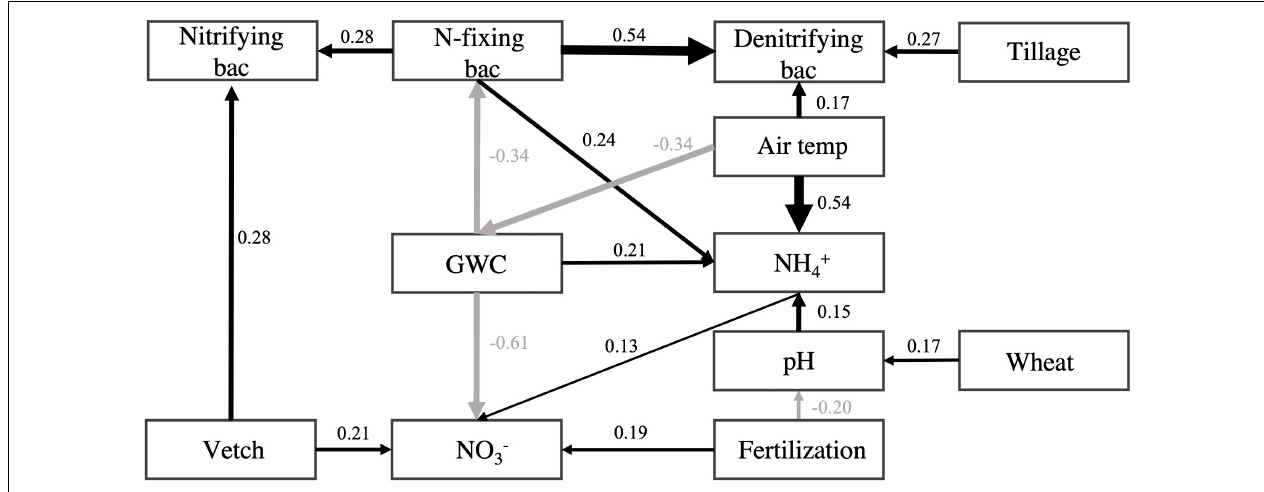
FIGURE 5 | Structural equation model for N-fixing, nitrifying, and denitrifying bacteria. Boxes represent variables. Single-headed arrows represent causal relationships. Black arrows indicate positive effects, and gray arrows indicate negative effects. No arrows suggest no significant relationships between variables. All presented relationships are significant at p < 0.05. Numbers beside each arrow are standardized path coefficients (i.e., effect sizes). See Supplementary Table 3 for standardized total effects. The “Vetch” and “Wheat,” “Tillage,” and “Fertilization” were presenting the cover cropping, conventional tillage, and inorganic N fertilization treatment, respectively. Soil pH (pH), gravimetric water content (GWC), ammonia-N (NH 4 + ), and nitrate-N (NO 3 − ), air temperature (month average ahead of sampling date) presented in rectangular